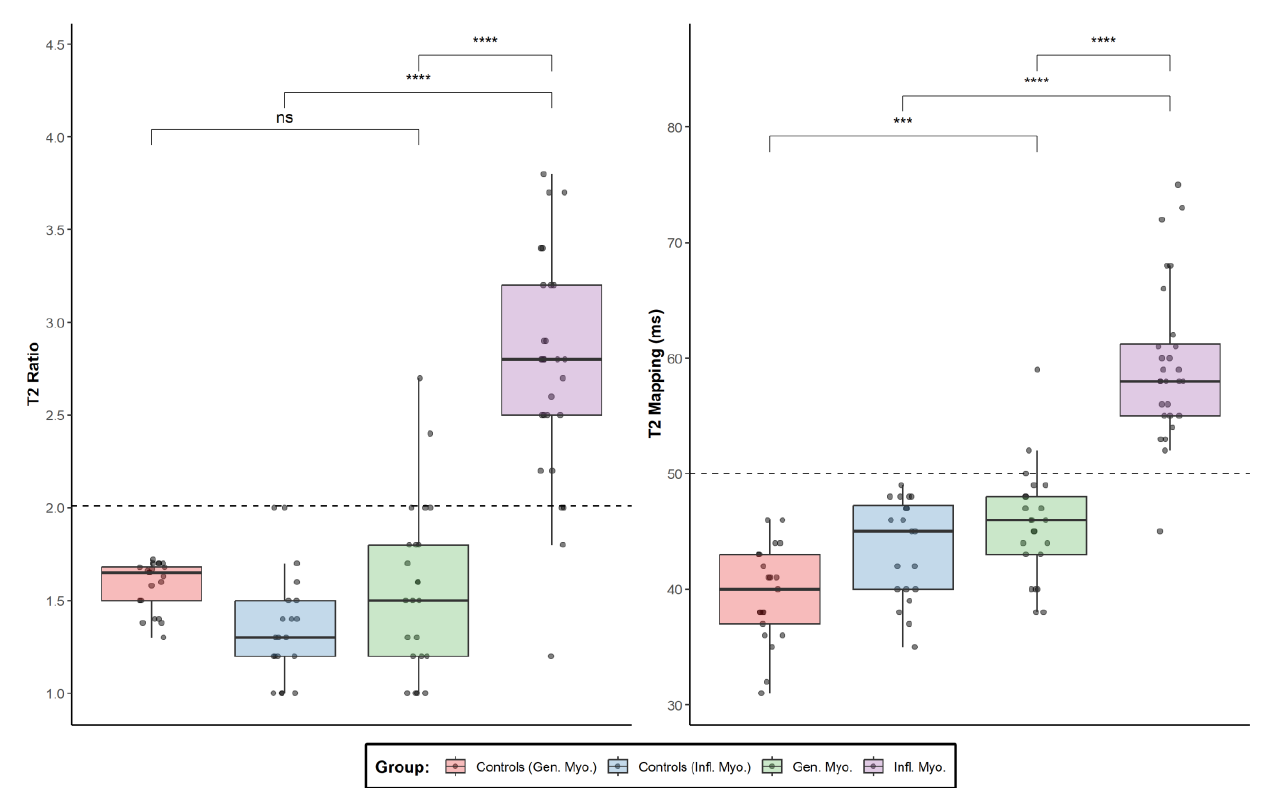
Figure 2. Boxplots and individual data points for T2-based CMR indices. p -values for individual comparisons are presented numerically in the corresponding tables (Tables 1 – 3). Cut-off points for defining normal values are denoted with dashed lines for each measurement. CMR: cardiovascular